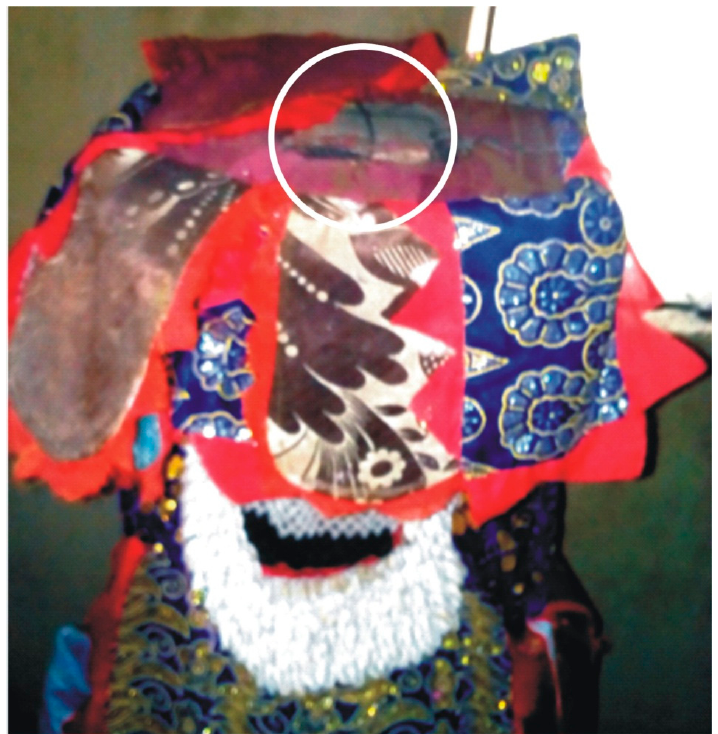
Figure 10. The circled part shows the hidden Ifá literature and ikin embedded under the èkú. Source: Photograph by